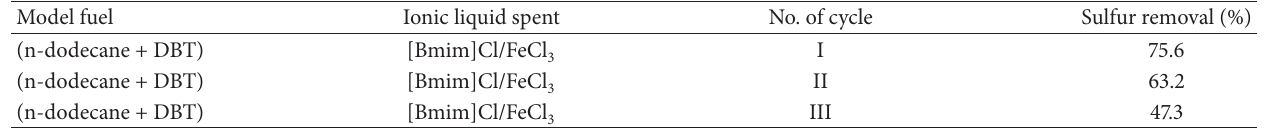
Table 2: Sulfur removal of [Bmim]Cl which was reused for three times in model liquid fuel (n-dodecane +